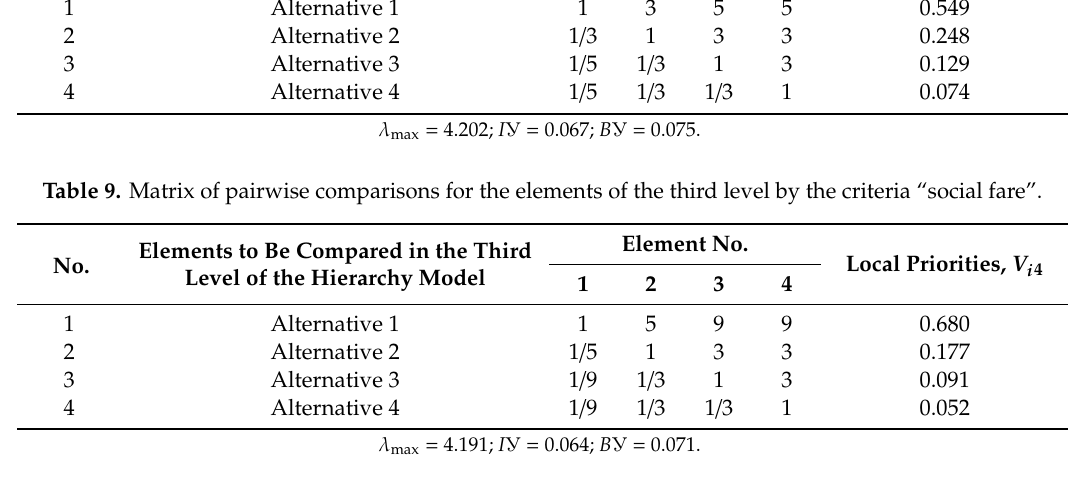
Table 8. Matrix of pairwise comparisons for the elements of the third level by the criteria “Sta ff costs”. Elements to Be Compared in the Third No. Level of the Hierarchy Model Alternative 2